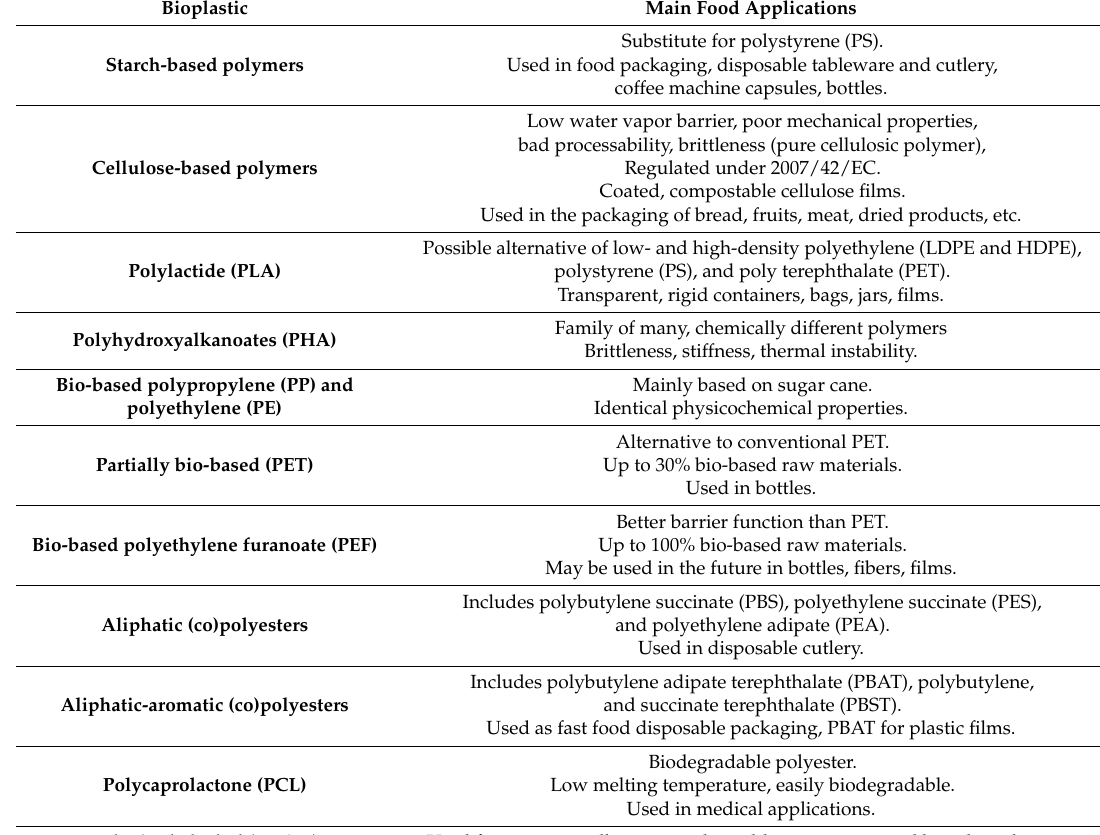
Table 2. Bioplastics as food contact materials [129].